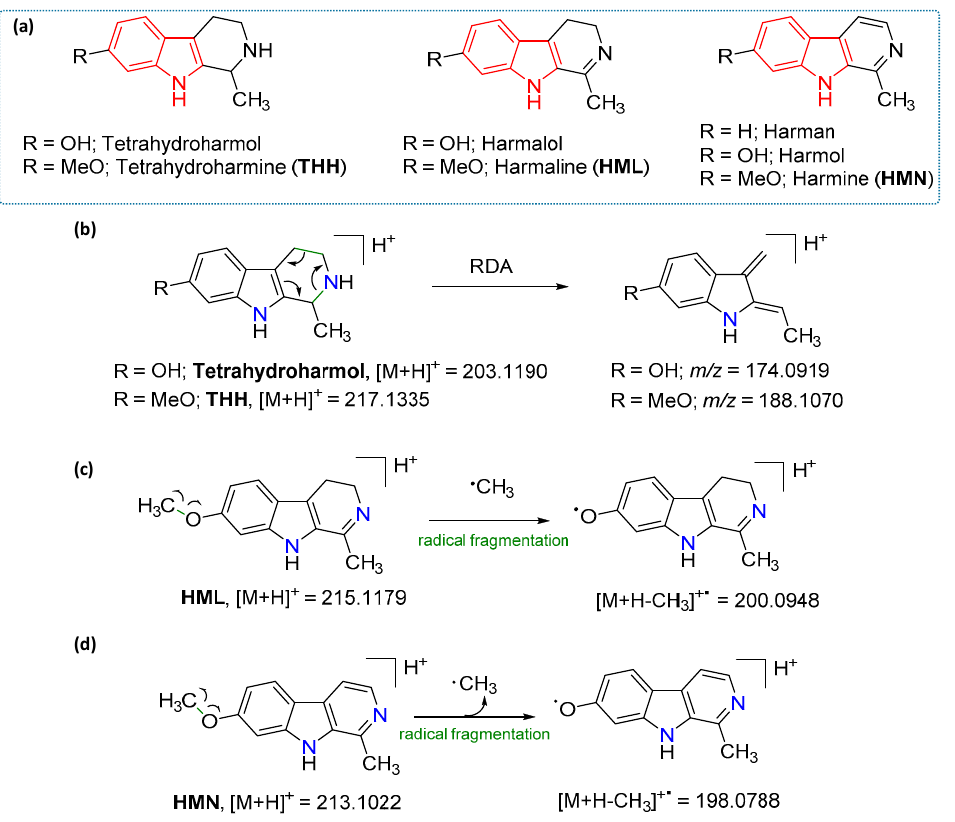
Figure 3. ( a ) Structures of the beta-carboline alkaloids detected from the methanolic extracts. ( b – d ). Detail of the main fragment ions and the fragmentation pathways proposed.